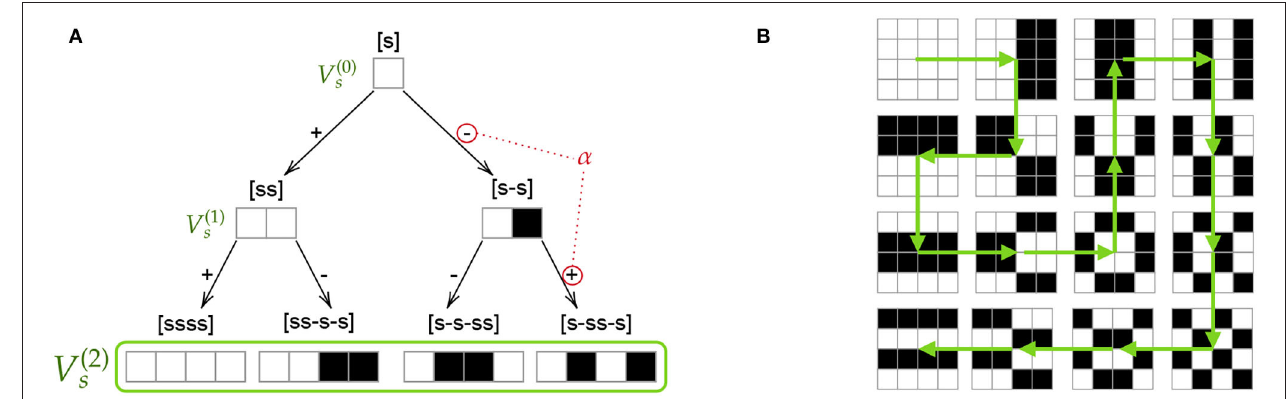
FIGURE 1 | (A) Example of a binary tree with k = 2 generating one-dimensional Gray-Code Kernels (GCKs) of size 4. (B) Example of ordering (on 2D GCKs) that forms a Gray Code Sequence, hence enabling the efficient application of successive